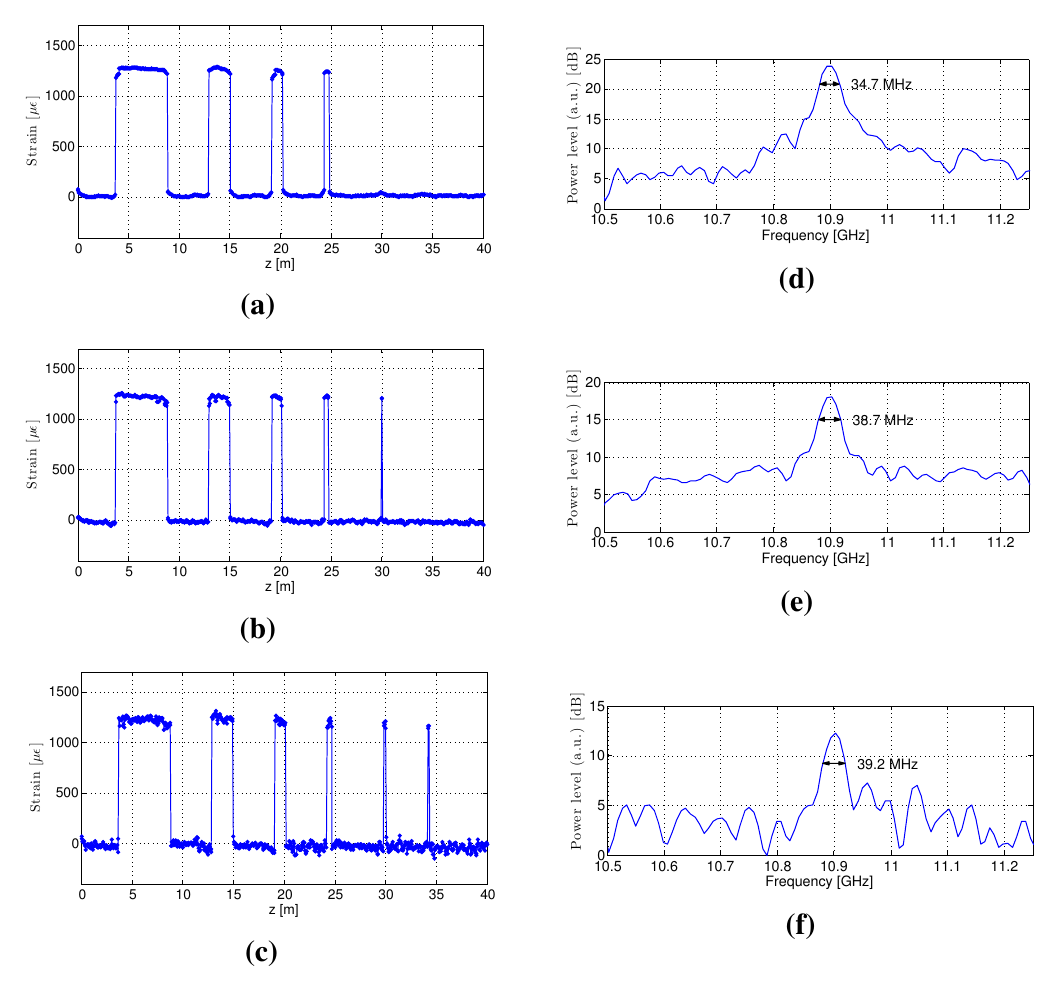
Figure 16. Experimental S-BOTDR results: ( a–c ) Strain estimates of Cases 1 to 3; ( d–f ) composite Brillouin spectrums at the 5-m strain interval of Cases 1 to